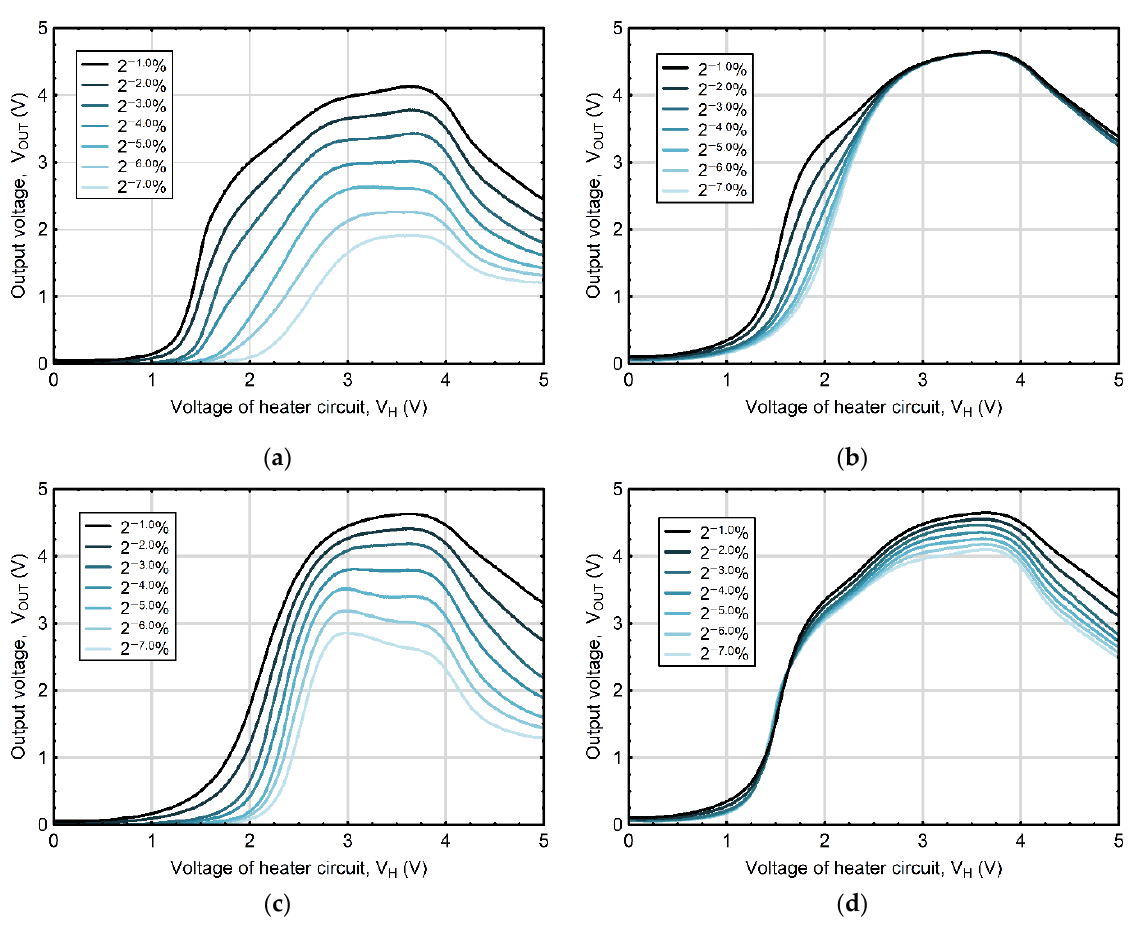
Figure 4. The voltage output signal of the TGS2610-C gas sensor with temperature modulation for different concentrations of ( a ) ethanol alone, ( b ) ethanol at the maximum analyzed level of acetone (0.5%), ( c ) acetone alone, and ( d ) acetone at the maximum analyzed level of ethanol (0.5%). For transparency and legibility, the graphs show the voltage output signal of the thermally modulated gas sensor (TGS2610-C) for every second combination of the applied concentrations of tested analytes.